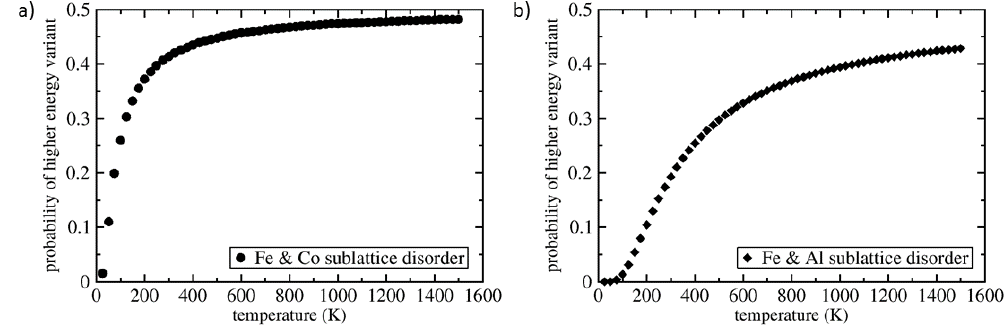
Figure 4. Estimated probabilities of occurrence of higher-energy polymorphs employing Boltzmann statistics: ( a ) for the inverse Heusler phase and ( b ) for the polymorph depicted in Figure